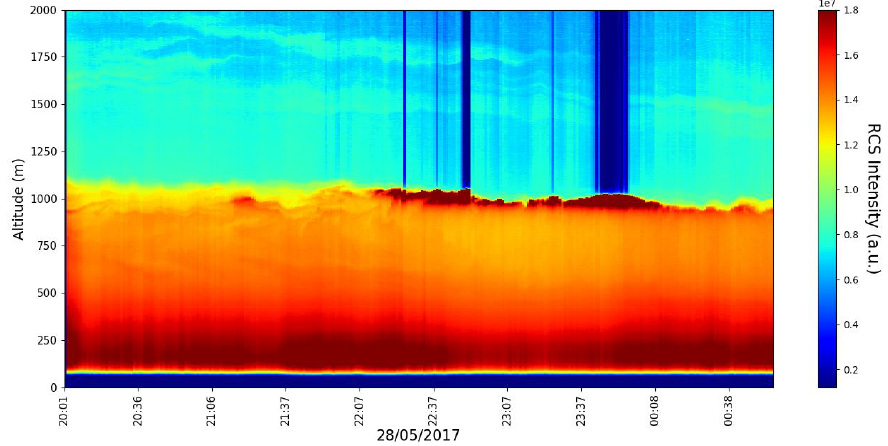
Figure 10. RCS profile timeseries, profiling rate 1/min, 28 April 2017.